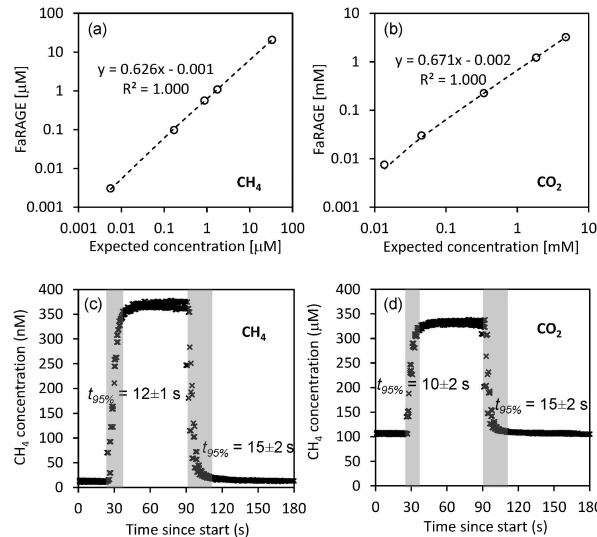
Figure 2. Performance of the Fast-Response Automated Gas Equi- librator (FaRAGE with a 2m tube in the gas–water mixing unit) for both dissolved CH 4 and CO 2 . (a, b) Correction equations for dissolved CH 4 and CO 2 , respectively, by referring FaRAGE mea- surements to expected concentrations measured using the manual headspace method. The dashed lines show a linear fit and the equa- tions are shown next to the lines. Note that in the two graphs both axes are log transformed. (c, d) Exemplary response time of FaRAGE for low-to-high and high-to-low concentration changes (water-to-gas mixing ratio 0.5). Triplicated tests were performed and the average response time was taken at the time point when 95% of the final concentration was